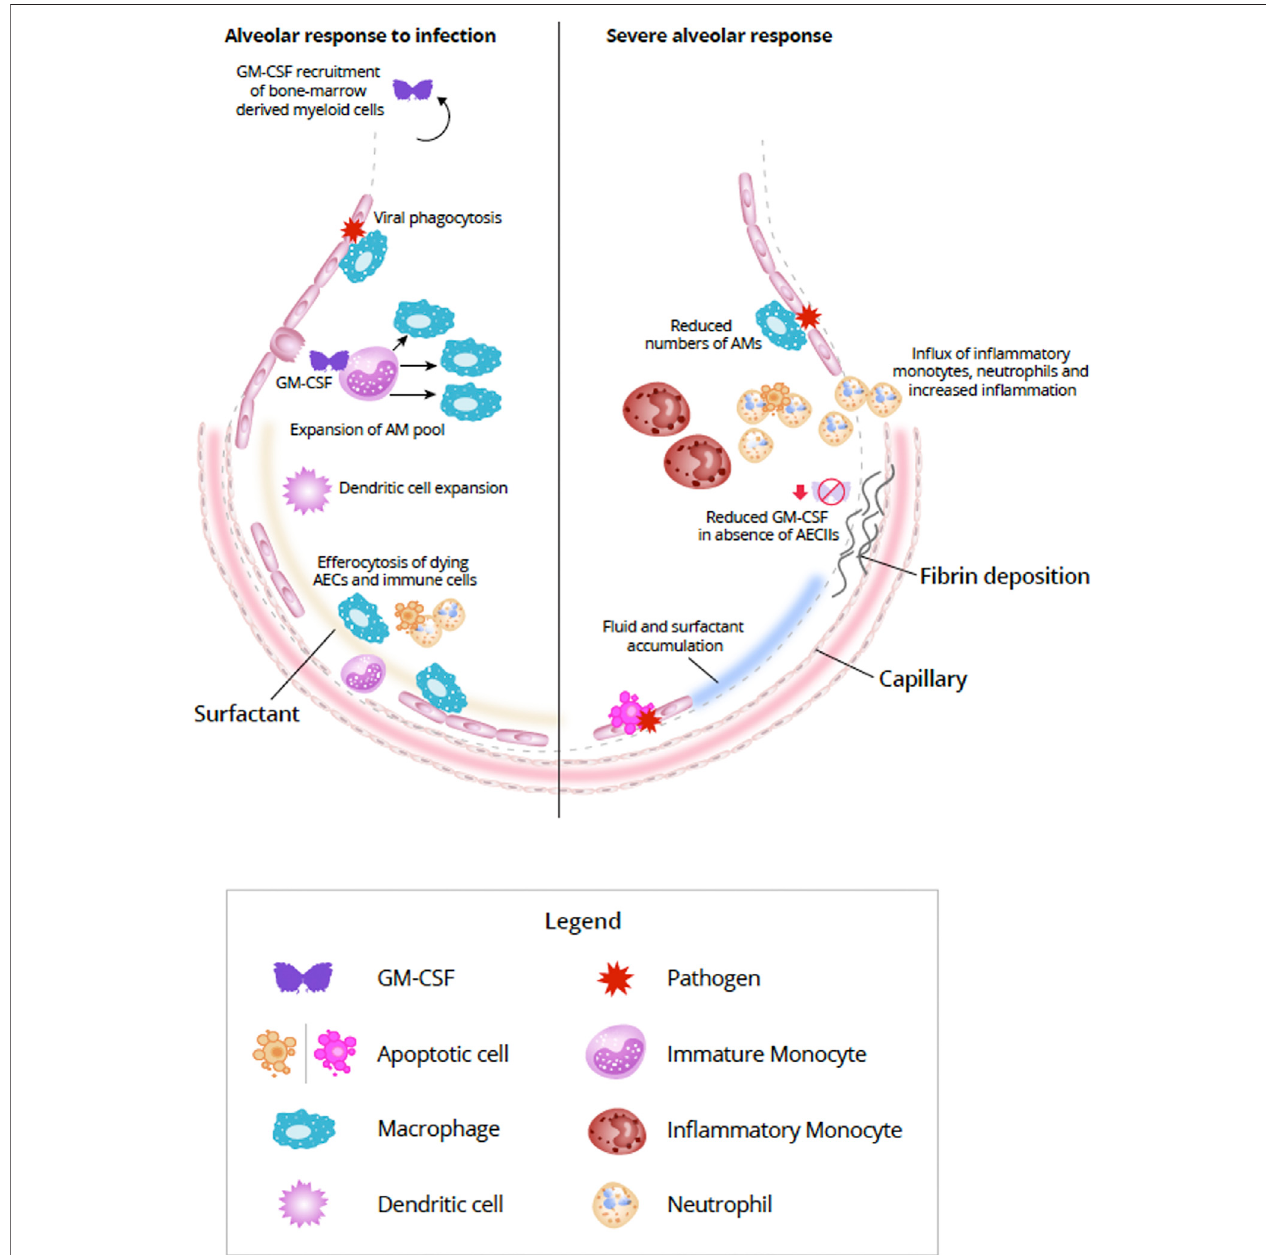
FIGURE 2 | Alveolar response to viral infection (left) and severe destruction of AECs (right) (Adapted from Guillot et al., 2013). In response to lung infection, AECs and AM initiate an immunologic response (Iwasaki et al., 2017). Increased expression of GM-CSF from AECII induces differentiation of monocytes and expands the AM pool (Morales-Nebreda et al., 2015). In addition bone marrow-derived monocytes can also be summoned by alveolar-derived GM-CSF, but during mild infections proliferation of resident AM is generally suf fi cient (Misharin et al., 2017; Guilliams et al., 2020). In addition to viral phagocytosis, AMs also act to efferocytose apoptosingAECsandimmunecells(TrapnellandWhitsett,2002;Ortega-Gomezetal.,2013;Boada-Romeroetal.,2020;Evrenetal.,2020).InteractionbetweenAECs andAMshelpstorepairdamagetothealveolarepitheliumbyexpansionofAECIviaAECIItransdifferentiation(AspalandZemans,2020).WithseveredestructionofAECs (right) lack of viable or suf fi cient AECs can compromise the repair process resulting in alveolar-capillary damage, accumulation of fl uid and surfactant, increased production of in fl ammatory molecules, and in fl ux of in fl ammatory cells, such as in fl ammatory monocytes and neutrophils (Pison et al., 1988; Aranda-Valderrama and Kaynar, 2018; Guillamat-Prats et al., 2018; Liao et al., 2020). Fibroblasts are activated in response to the damage and can lead to fi brotic scarring (Beers and Morrisey, 2011;Spagnoloetal.,2020).Abbreviations:AECI,alveolarepithelialcelltypeI;AECII,alveolarepithelialcelltypeII;AM,alveolarmacrophage;DC,dendriticcell;GM-CSF, granulocyte-macrophage colony-stimulating